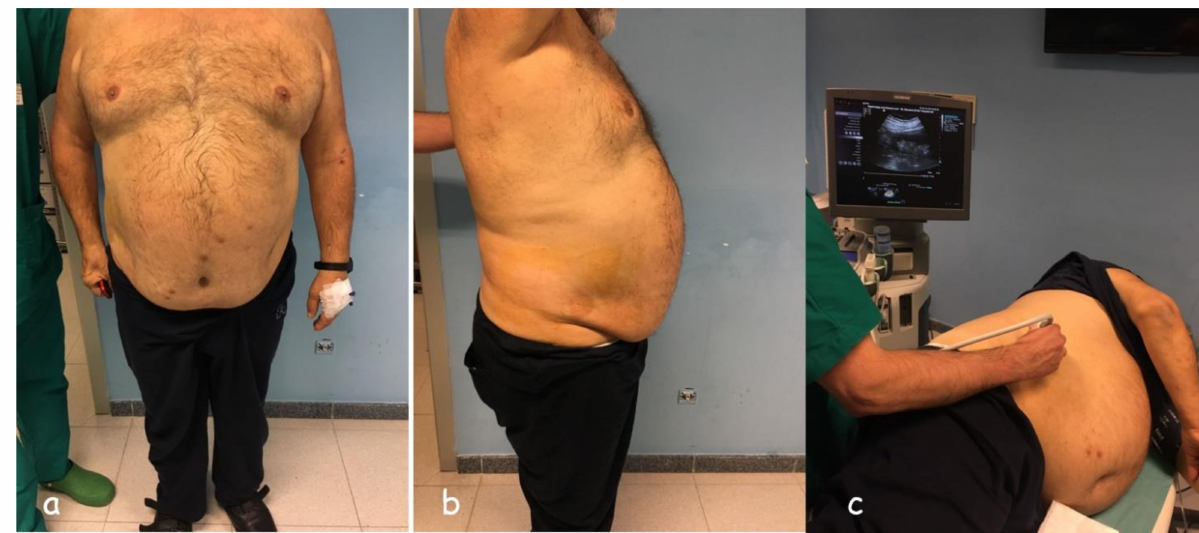
Figure 6. Supine antero-lateral position (SALP) is indicated in patients who are obese ( a ), ( b ); ( c ) pre-bioptic